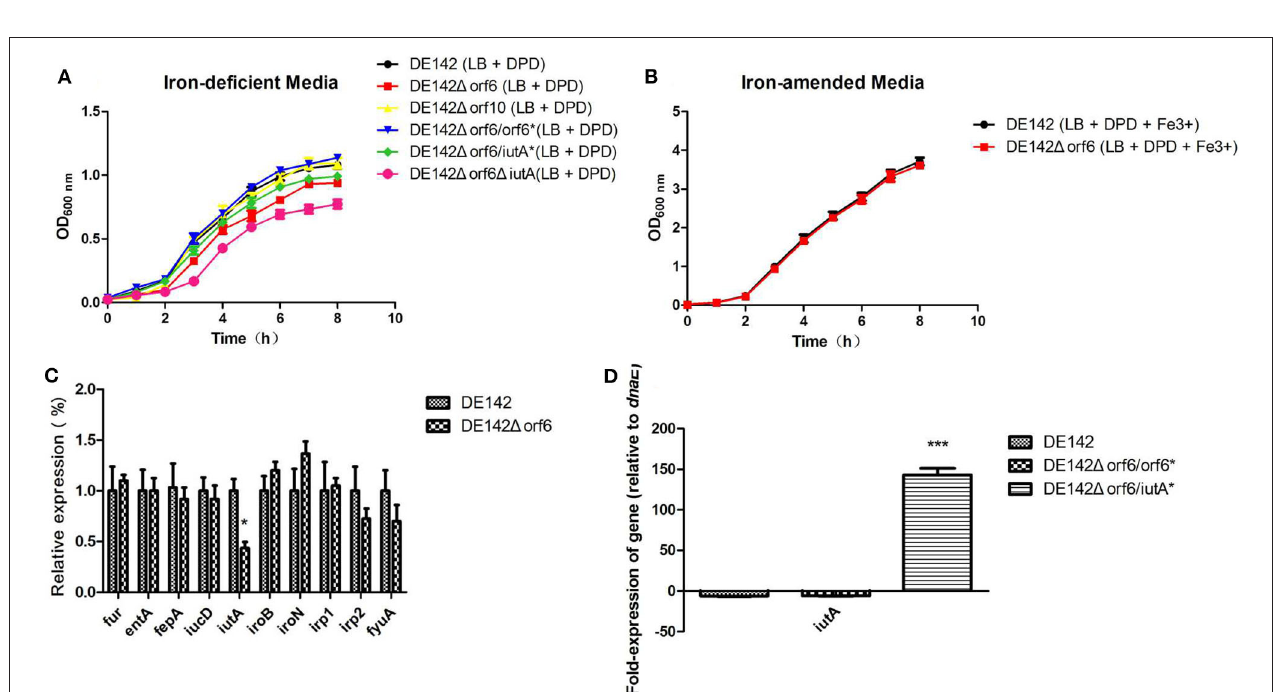
FIGURE 2 | Strain growth in iron-deficient conditions. (A) The growth curve of the wild-type strain DE142 and its derivative strains in iron-deficient media (100 µ M 2,2-dipyridyl added into LB broth). (B) The growth curve of the wild-type strain DE142 and its mutant strains in iron-amended media (70 µ M FeCl 3 was supplemented to iron-deficient media). (C) Expression of Fe-acquisition genes. Expression of Fe acquisition genes in the wild-type strain DE142 and the mutant strain DE142 1 orf6 was measured by RT-PCR. (D) Expression of iutA . The RNA was extracted from the bacteria grown in iron-deficient media. The acquired cycle threshold (CT) was normalized to the CT of the housekeeping gene dnaE . Data were presented as the mean ± SD of three independent experiments, with each experiment being composed of four individual measurements. Unpaired T -tests were performed for significance. * P < 0.05, *** P <